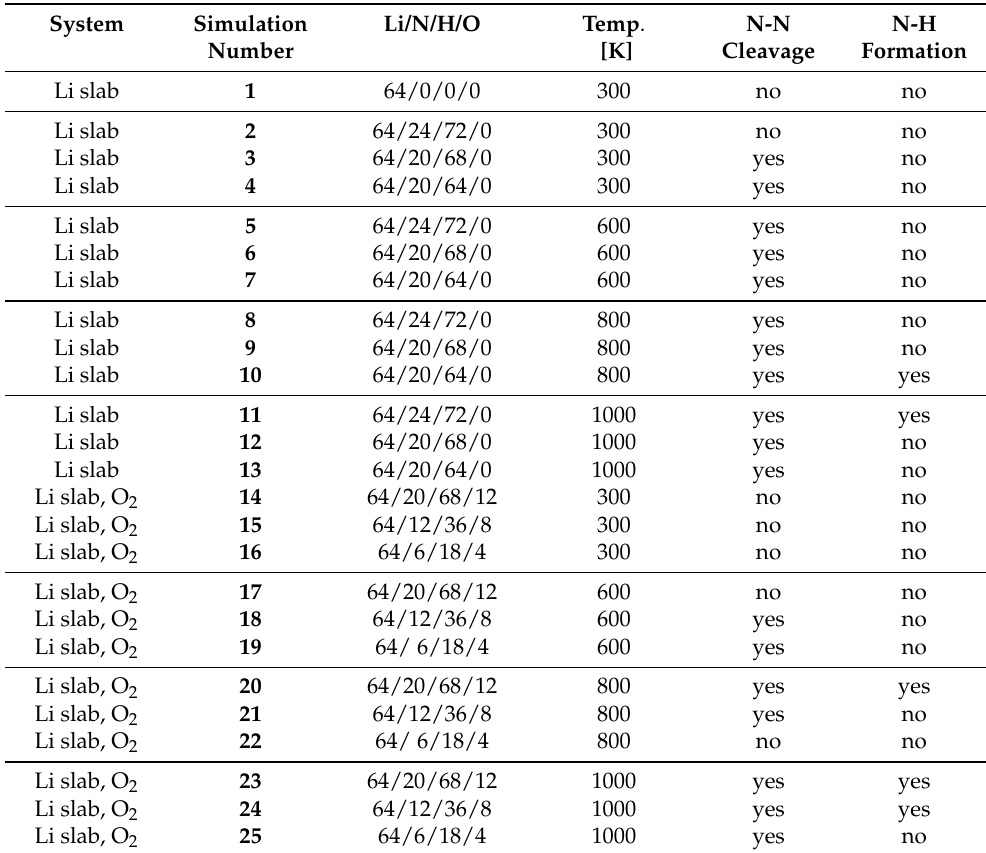
Table 1. Protocol of the CPMD simulations containing nitrogen and hydrogen discussed in this paper. Given are the numbers of Li, N, H, and O atoms in the single models and the initial temperature. Production runs are listed only, not the equilibration runs. Higher temperatures facilitate the reactions, while the effect of pressure is unclear. System Li/N/H/O Temp . N-N N-H